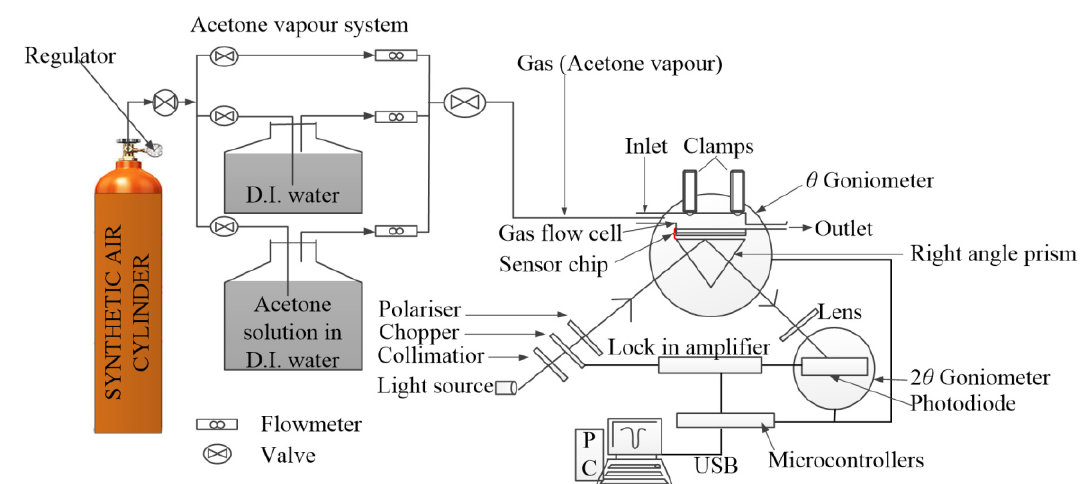
Figure 1. Schematic diagram of the entire SPR response testing setup.